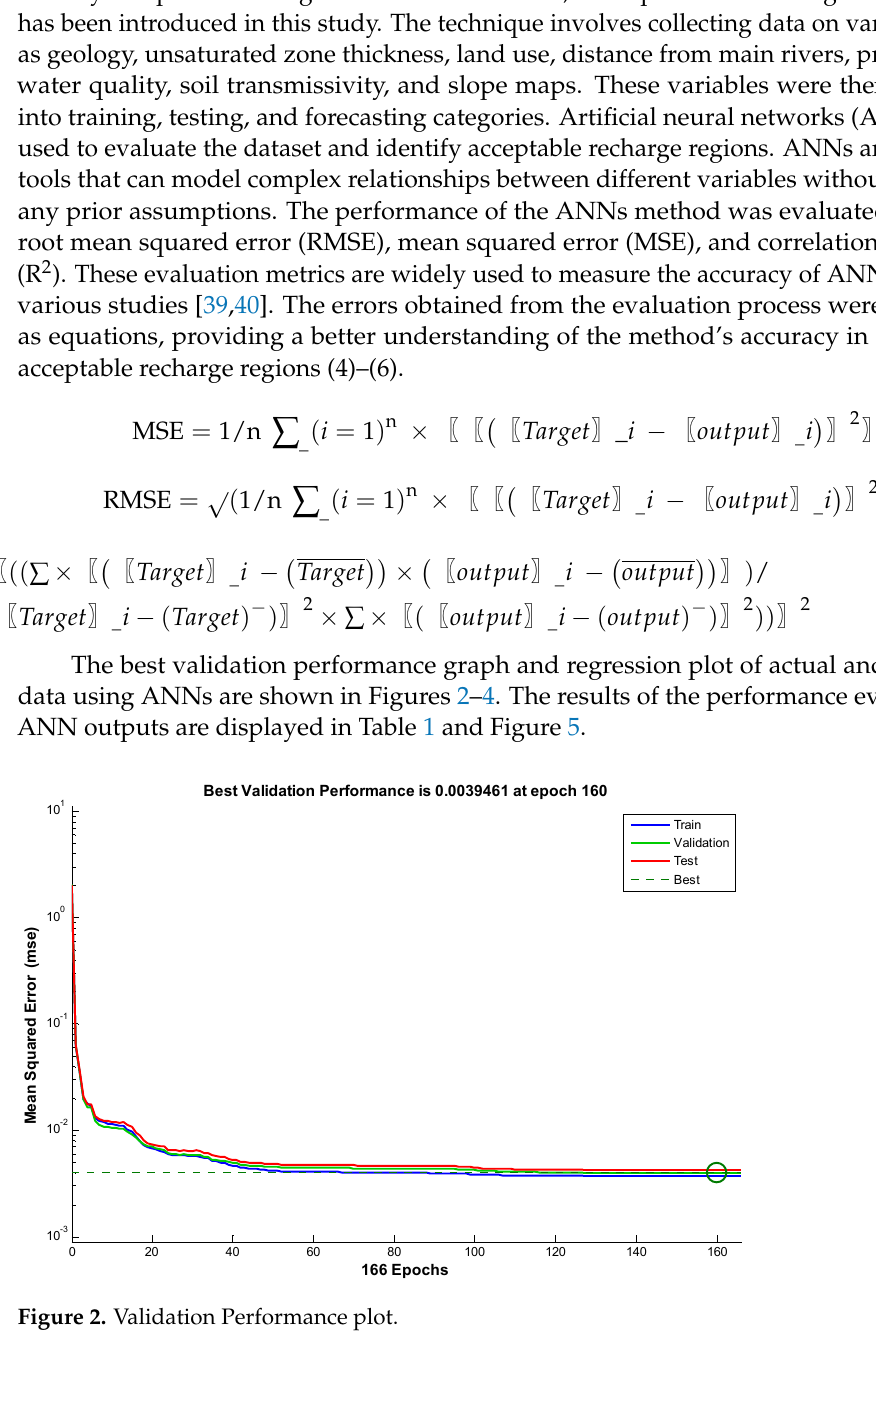
Figure 3. Data output and model performance criteria optimised via neural networks. The ML algorithm’s performance curves are depicted in Figures 2 and 3. There ap- pear to be no issues with performance. There is no evidence of overfitting on either the validation or test curves. When comparing the training and validation curves, the training curve flattens out more quickly, indicating that the trained network performs better with learning data. Table 1. ANN operation. BGWAN Process